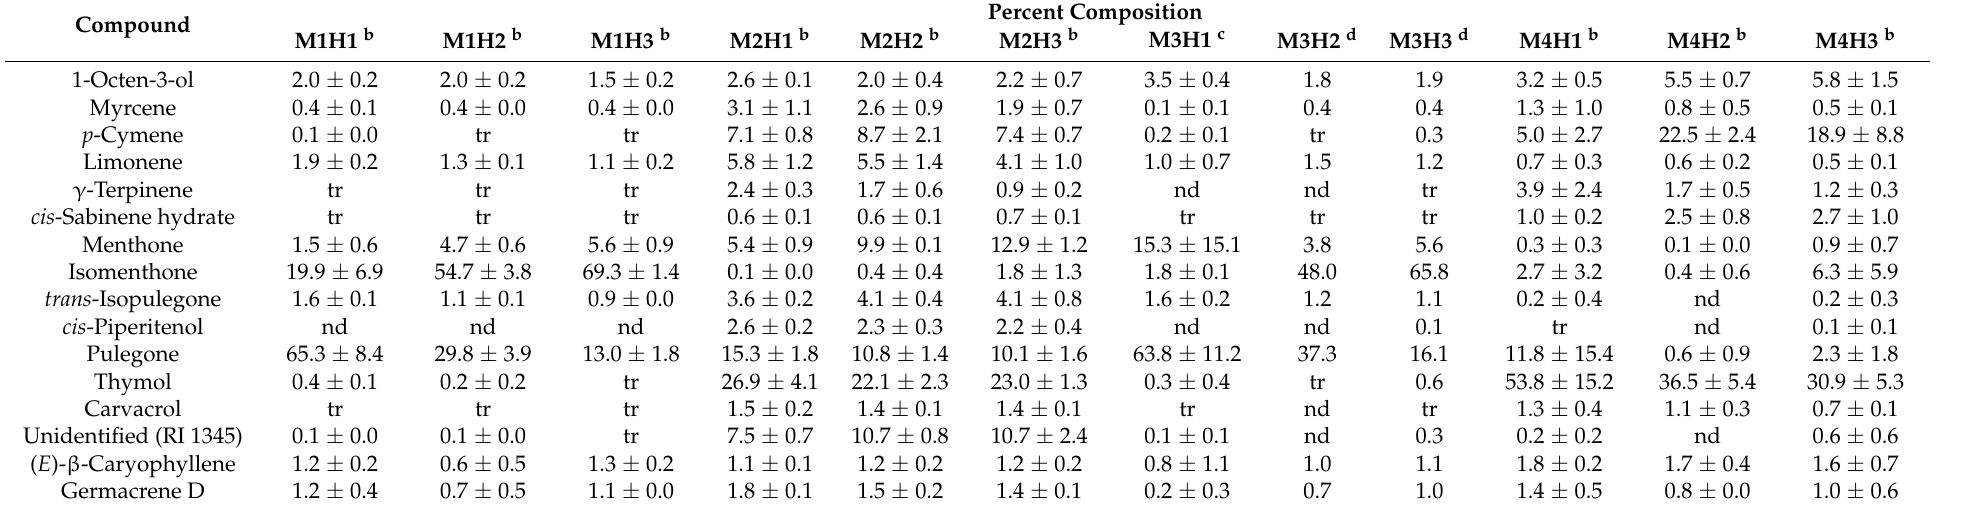
Table 1. Major components of Pycnanthemum virginianum essential oils cultivated in North Alabama a